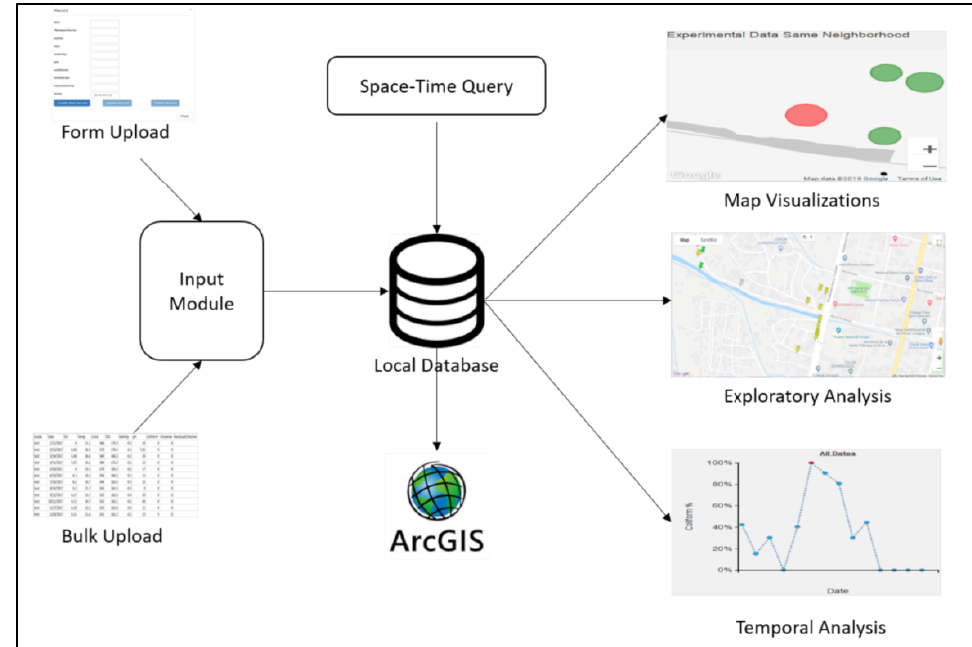
Figure 1. Schematic diagram for EpiExplorer with input, database, and exploratory module.